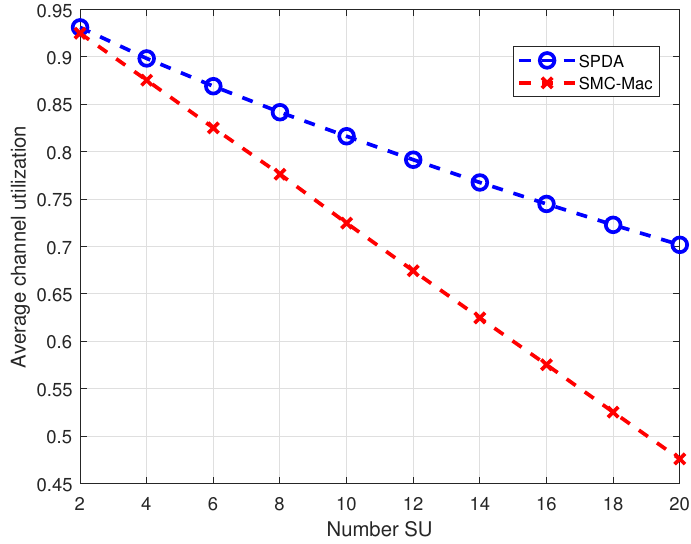
Figure 8. Average channel utilization at different number of